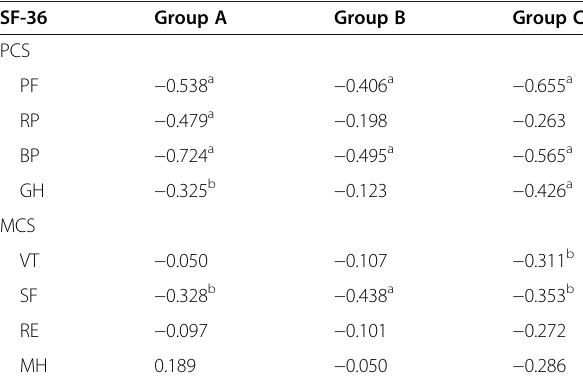
Table 4 Spearman correlation between different OKS